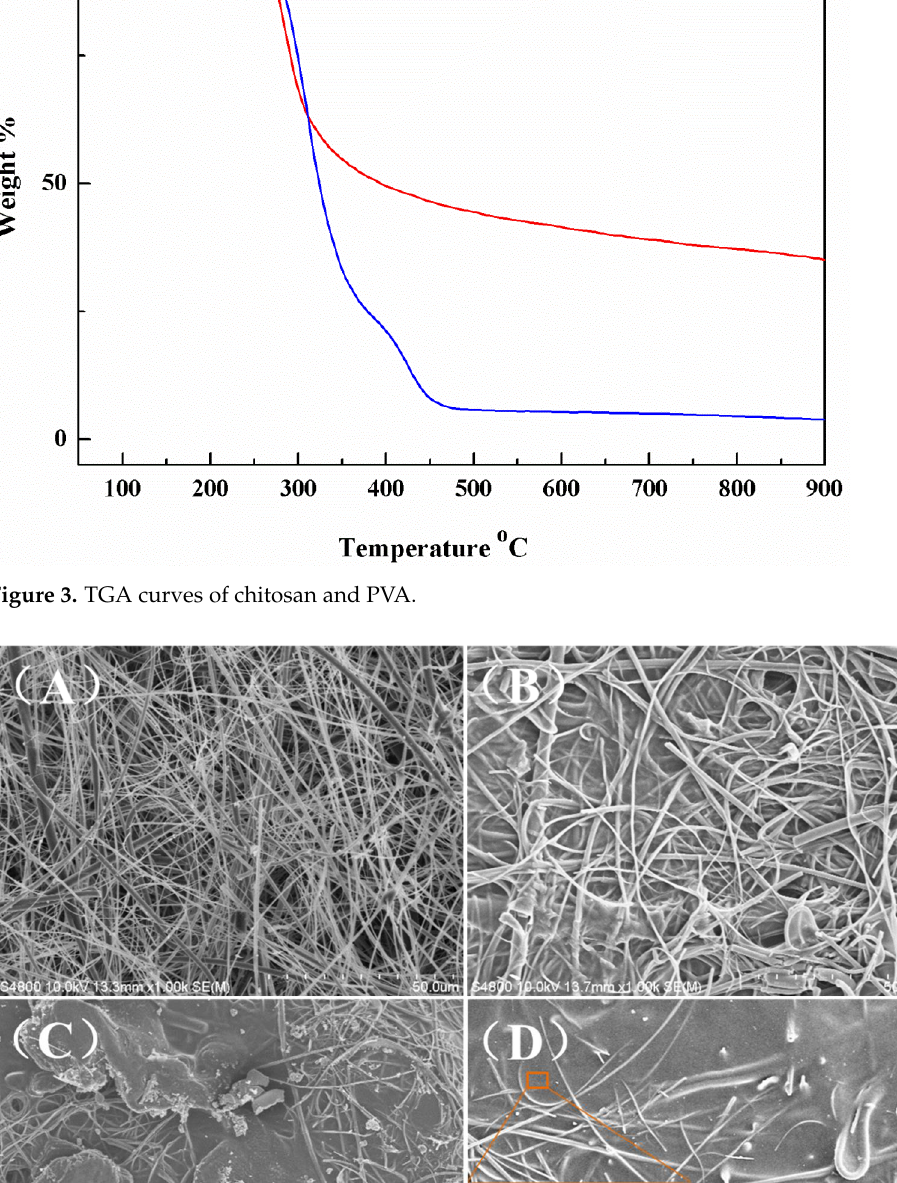
Figure 4. The surface morphology of the membranes. ( A ) glass fiber microporous membrane, ( B ) CS0, ( C ) CS4, and ( D )